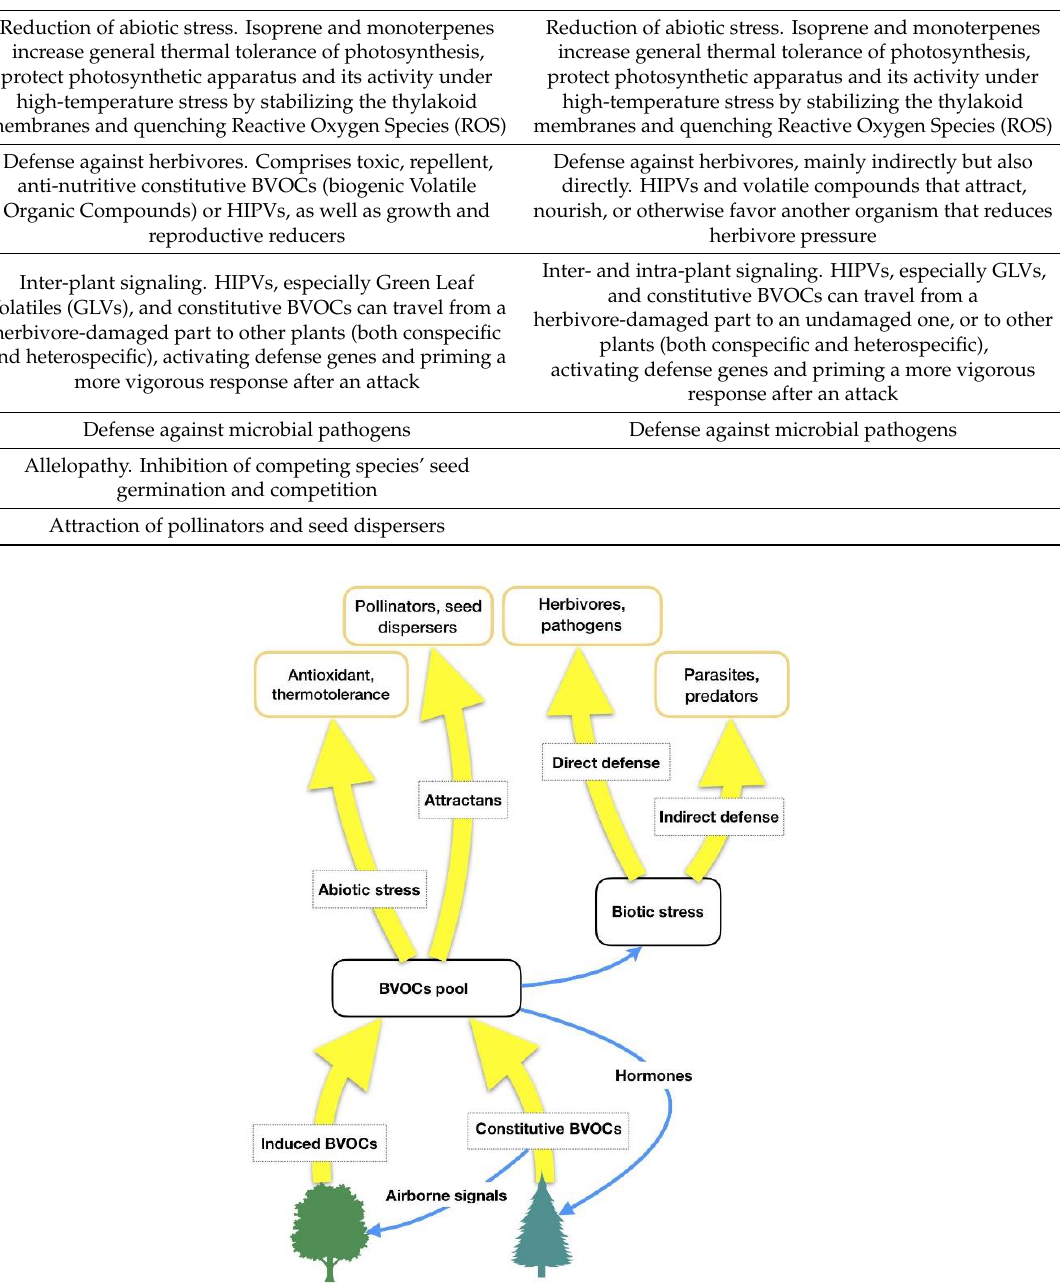
Table 1. Functions of constitutive and herbivore-induced forest Volatile Organic Compounds (VOCs). Constitutive Forest VOCs Herbivore-Induced Plant Volatiles (HIPVs)